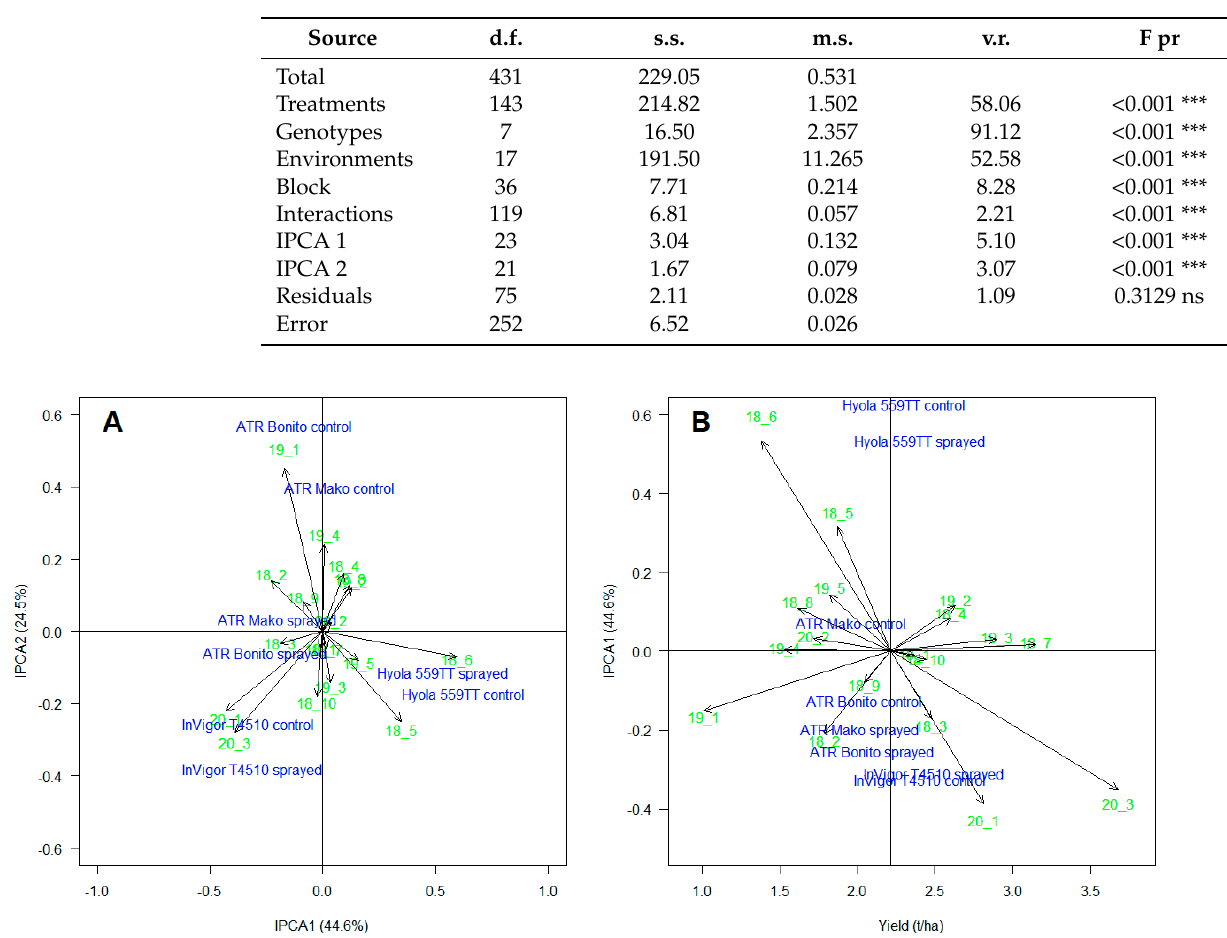
Table 4. Summary of treatment Additive Main effects and Multiplicative Interactions (AMMI) on canola yield (t/ha) for four varieties (ATR Bonito, Hyola 559TT, ATR Mako and InVigor T4510). Genotype represents Variety + Management. Sums of squares (s.s.), mean squares (m.s.), variance ratio (v.r.) and degrees of freedom (d.f.) are presented. Significance indicated by; ns, not significant, *** p < 0.001.